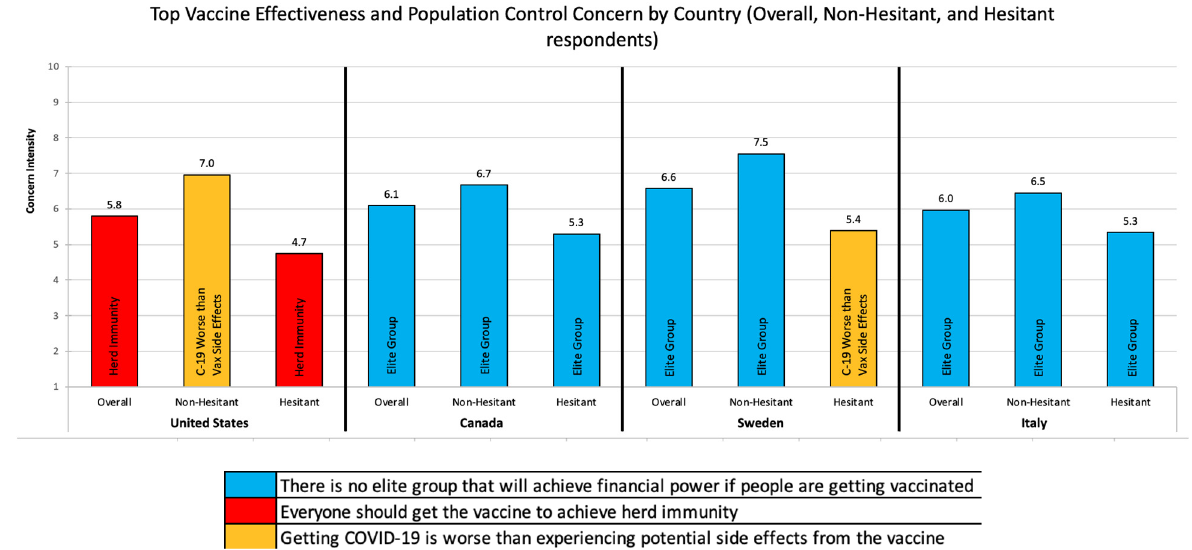
Figure 2. Top Vaccine Effectiveness and Population Control Concern by Country and Hesitancy Status.